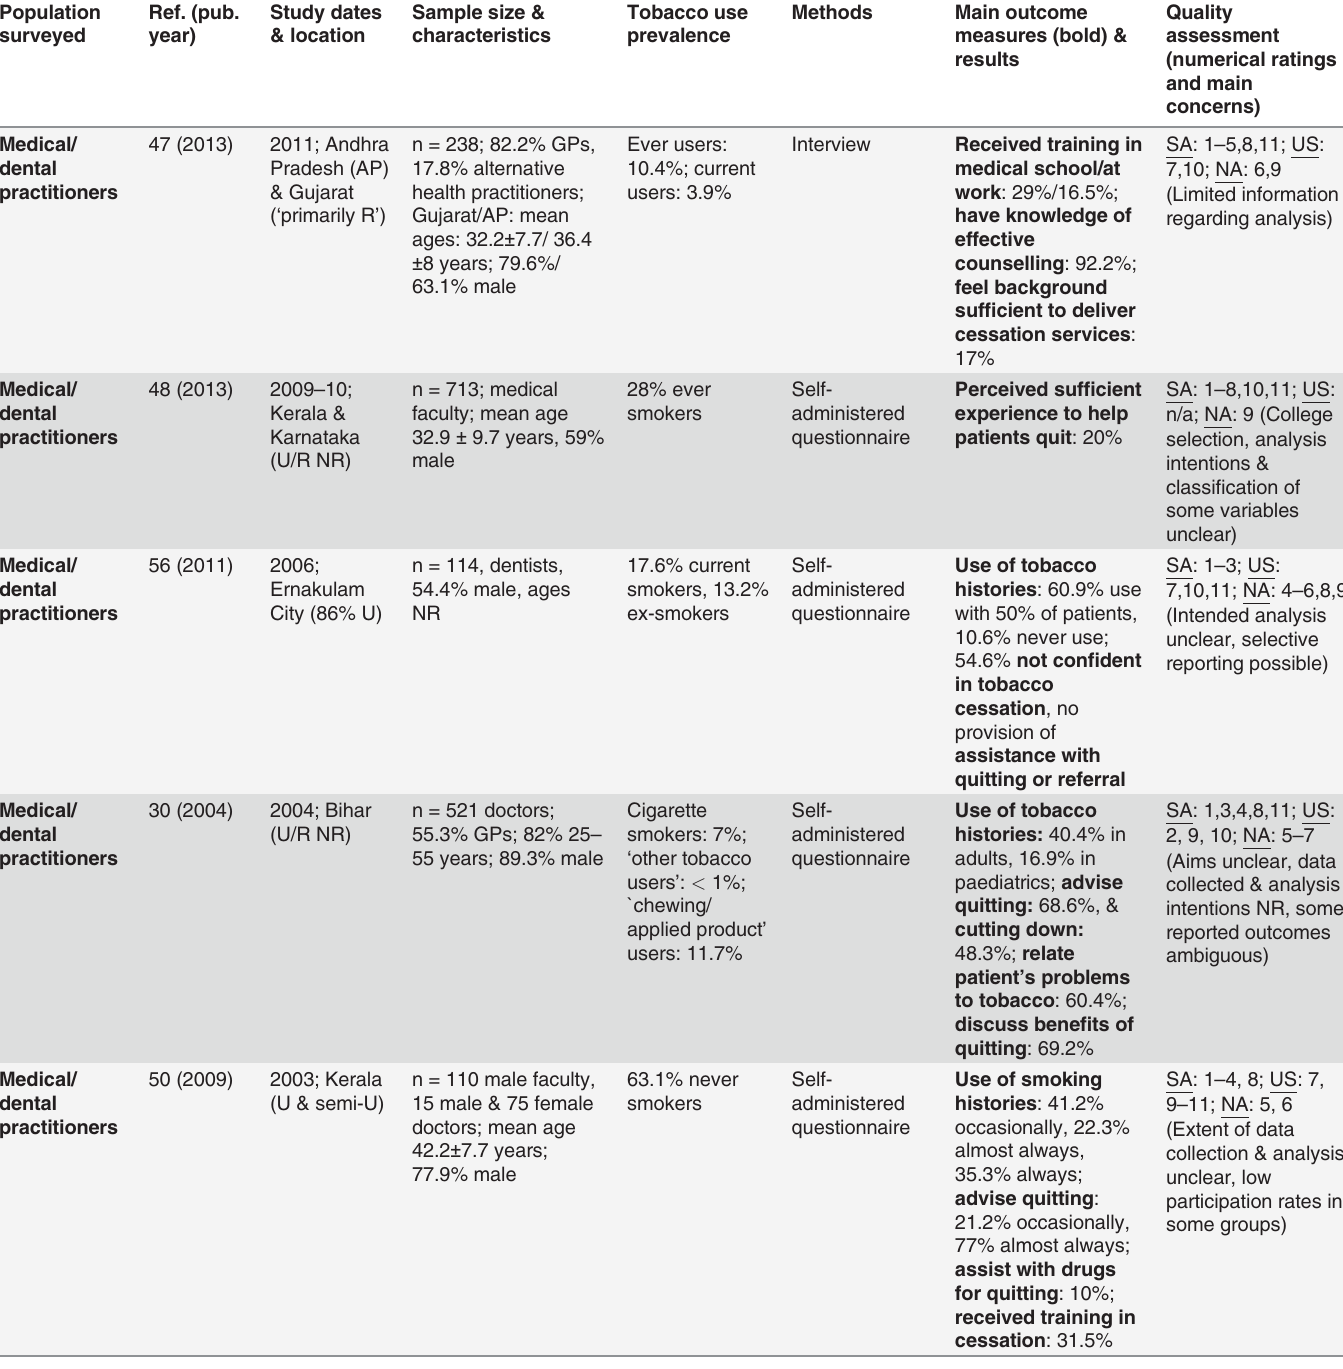
Table 6. Article 14: Demand reduction measures concerning tobacco dependence and cessation. Population